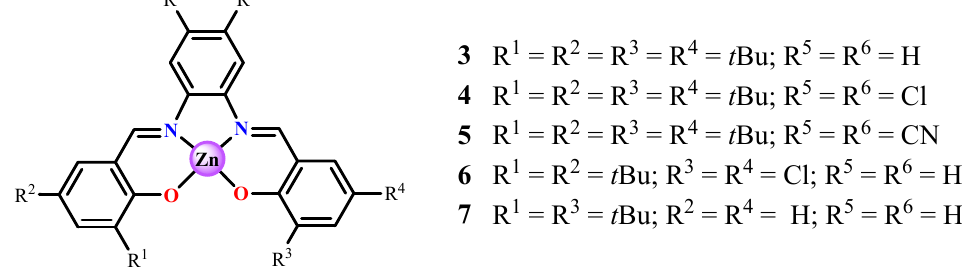
Figure 4. Structure of investigated substituted Zn(salphen) complexes.